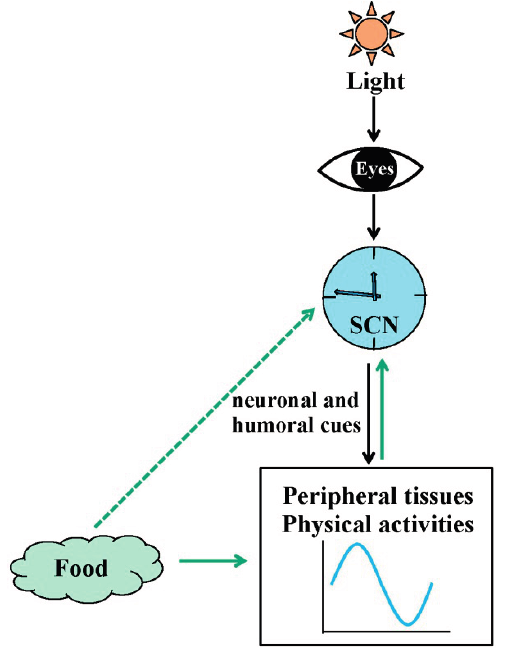
Figure 1. Resetting signals for the central and peripheral clocks. The suprachiasmatic nuclei (SCN) synchronize peripheral oscillators and physiological activities including metabolism, locomotor activity, the sleep-wake cycle, blood pressure, and body temperature via neuronal and humoral cues. Light, food, and feeding regimens affect the central clock in the SCN and/or peripheral